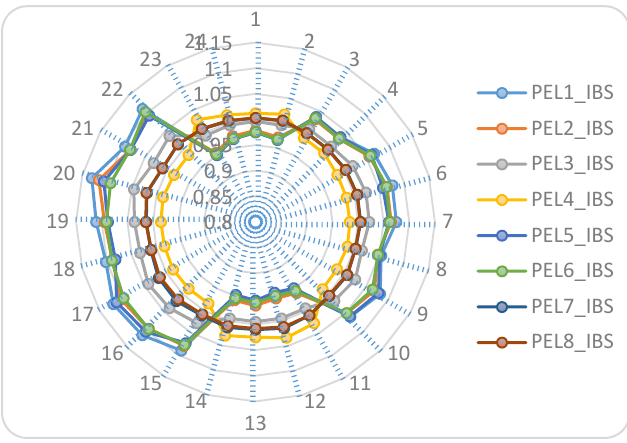
Figure 7. Interaction benefit satisfaction (IBS) of PELs.